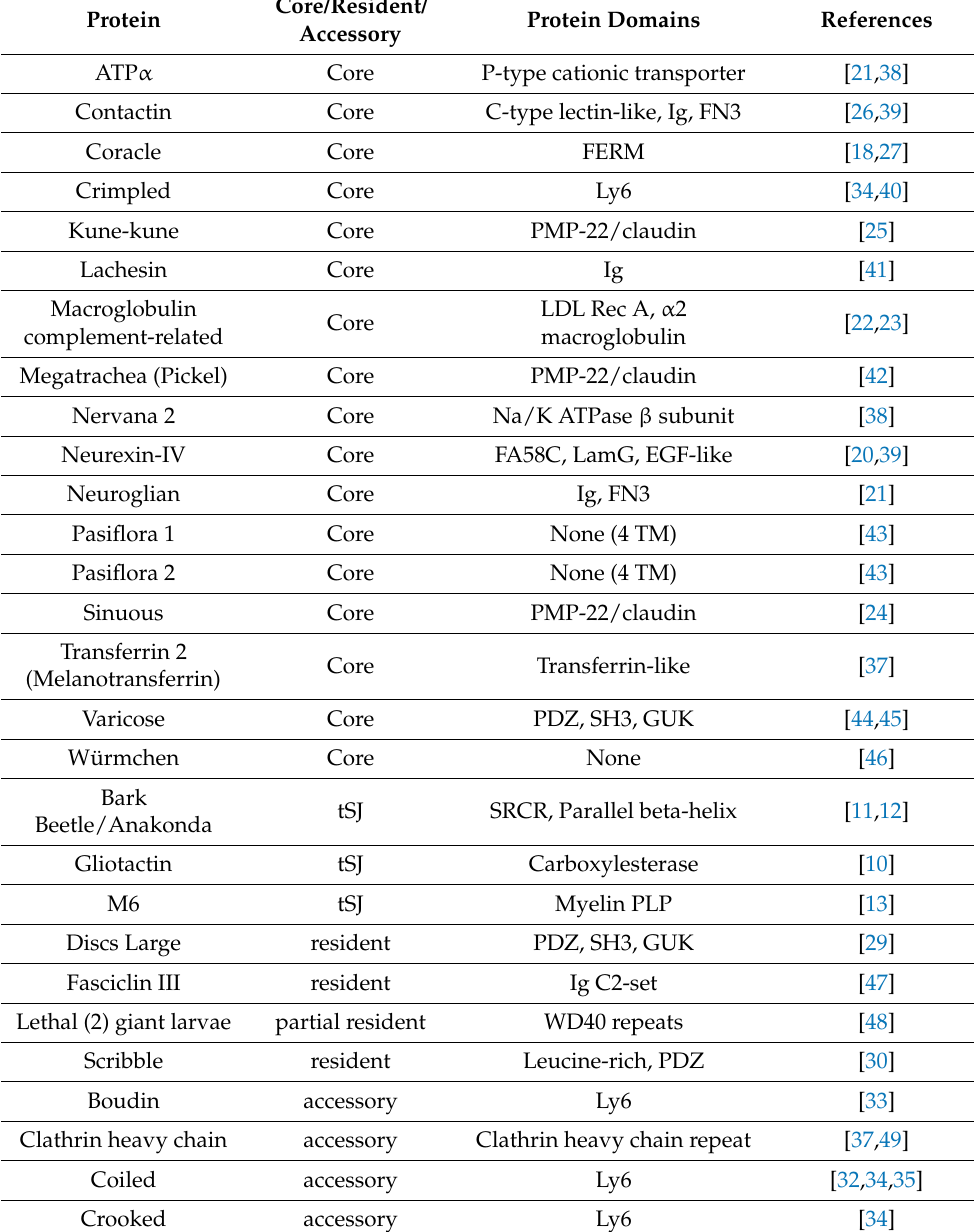
Table 1. Protein composition of the